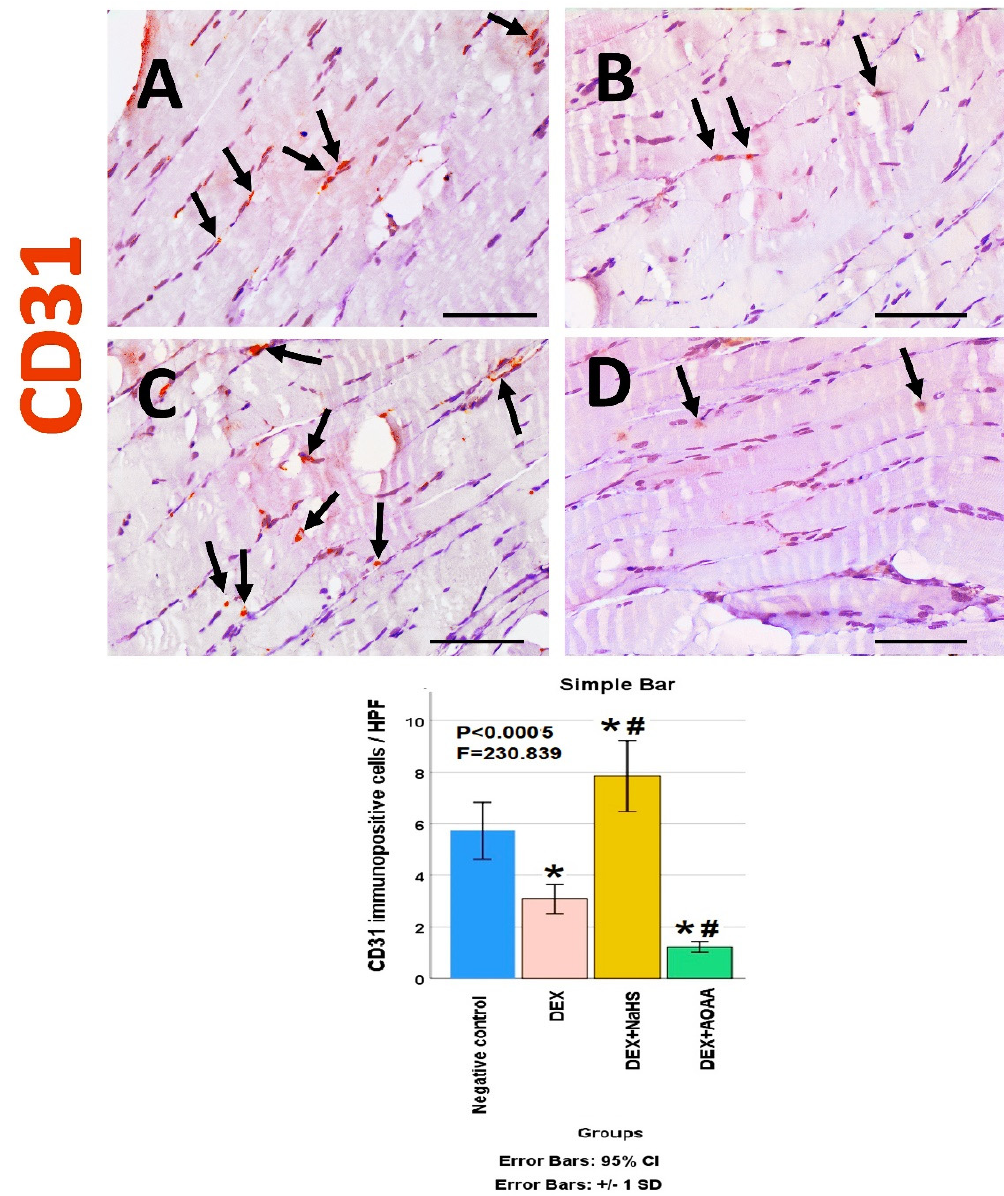
Figure 7. ( A − D ): Light-microscopic image of CD31 immunostaining ( × 400) in soleus muscle tissues of all studied groups; Negative control, Dex, Dex + NaHS, and Dex + AOAA groups ( A − D ; respec- tively). Scale bar = 25 µ m. Arrows: CD31 immunopositive cells. (E) The mean of the number of CD31 immunopositive cells/HPF in the studied groups. Results are mentioned as mean ± standard deviation. The test used: one-way ANOVA, followed by post-hoc Tukey test. p : significance (<0.05). *: significance as compared to the negative control group. #: significance as compared to (Dex) group. Dex: Dexamethasone, NaHS: Sodium hydrosulfide, and AOAA: Aminooxyacetic acid.